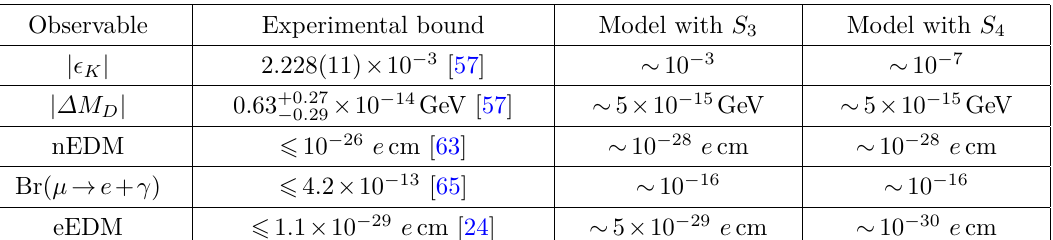
× U(1) H is also shown. We take 1 2 m q , m ‘ for squarks and sleptons, e e